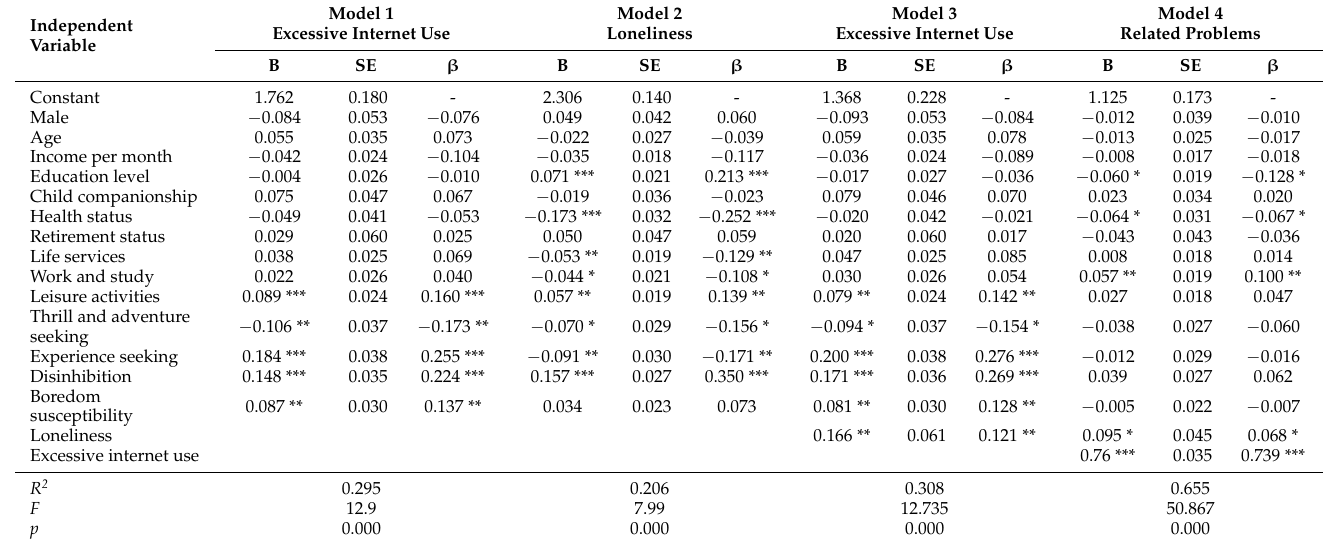
Table 4. Multiple regression